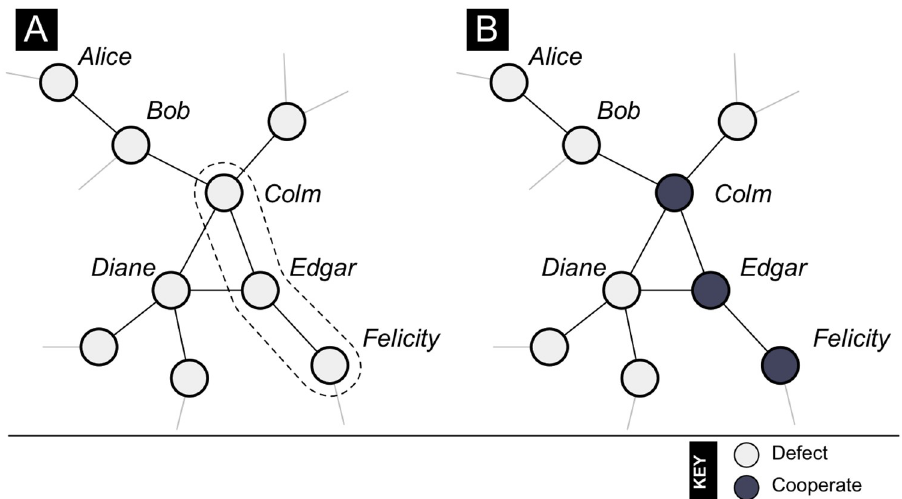
Fig 1. Collaborating to cooperate. Vertices indicate players, edges indicate interactions. Panel A : The graph restricted to the set of individuals { Colm , Edgar , Felicity } (dashed line) constitutes a connected sub-graph and so these individuals can occasionally collaborate in updating their strategies when it is profitable to do so. This is not the case for the set of individuals { Alice , Bob , Diane } as the graph restricted to this set is not connected. Panel B : Strategies following a collaborative decision by { Colm , Edgar , Felicity } to switch to the strategy Cooperate. Such a switch would be a coalitional better response at b = 4, c = 5, but not at b = 3, c = 4, as in the latter case Colm would lose payoff from such a